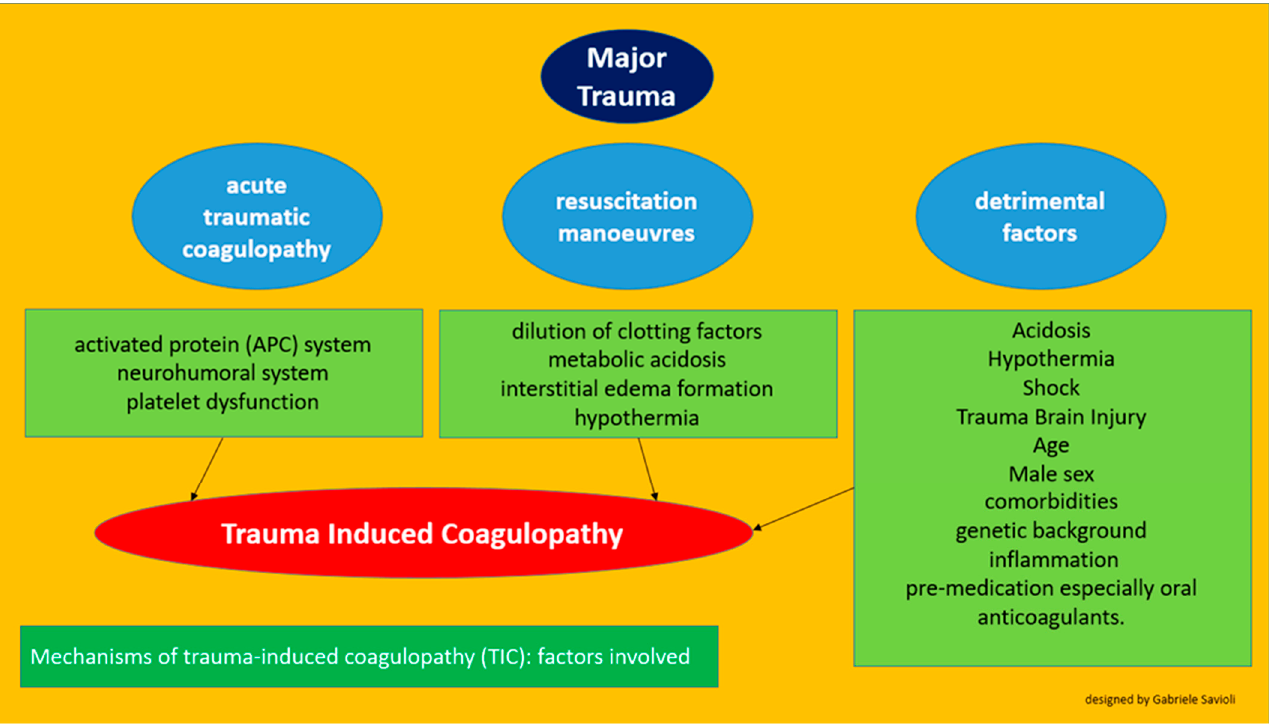
Figure 2. Factors involved in the development of trauma-induced cardiomyopathy.